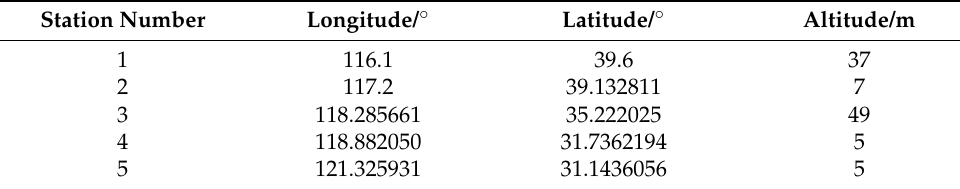
Table 2. Location information of ground stations.